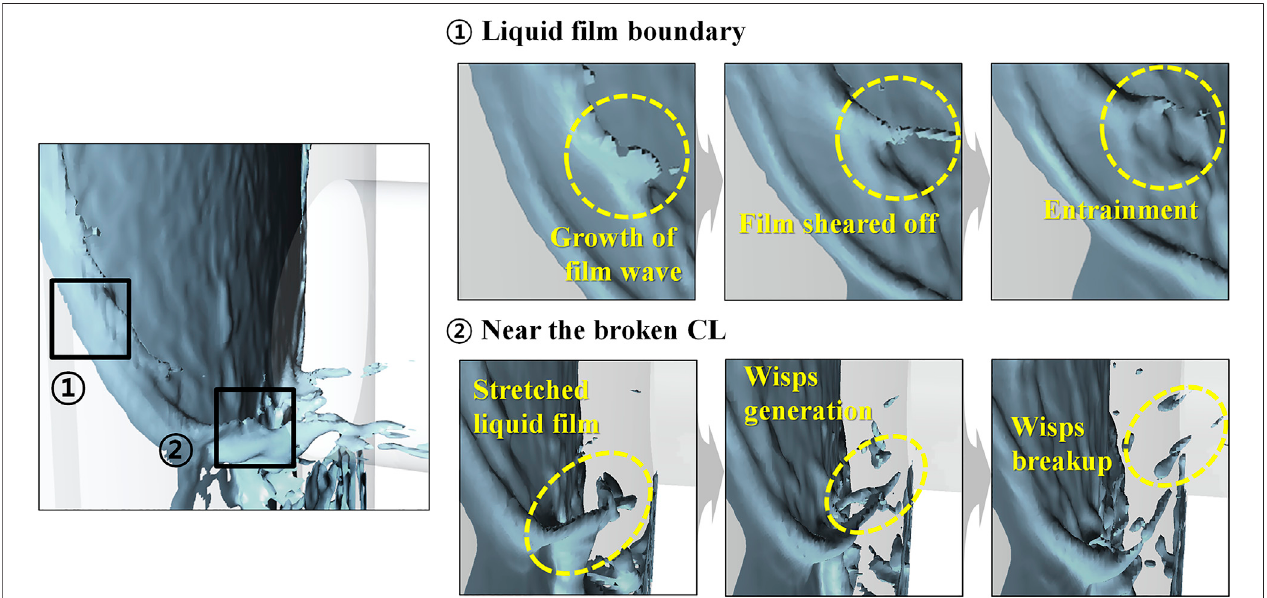
FIGURE 9 | Principal mechanisms of ECC bypass phenomenon (W063A24).